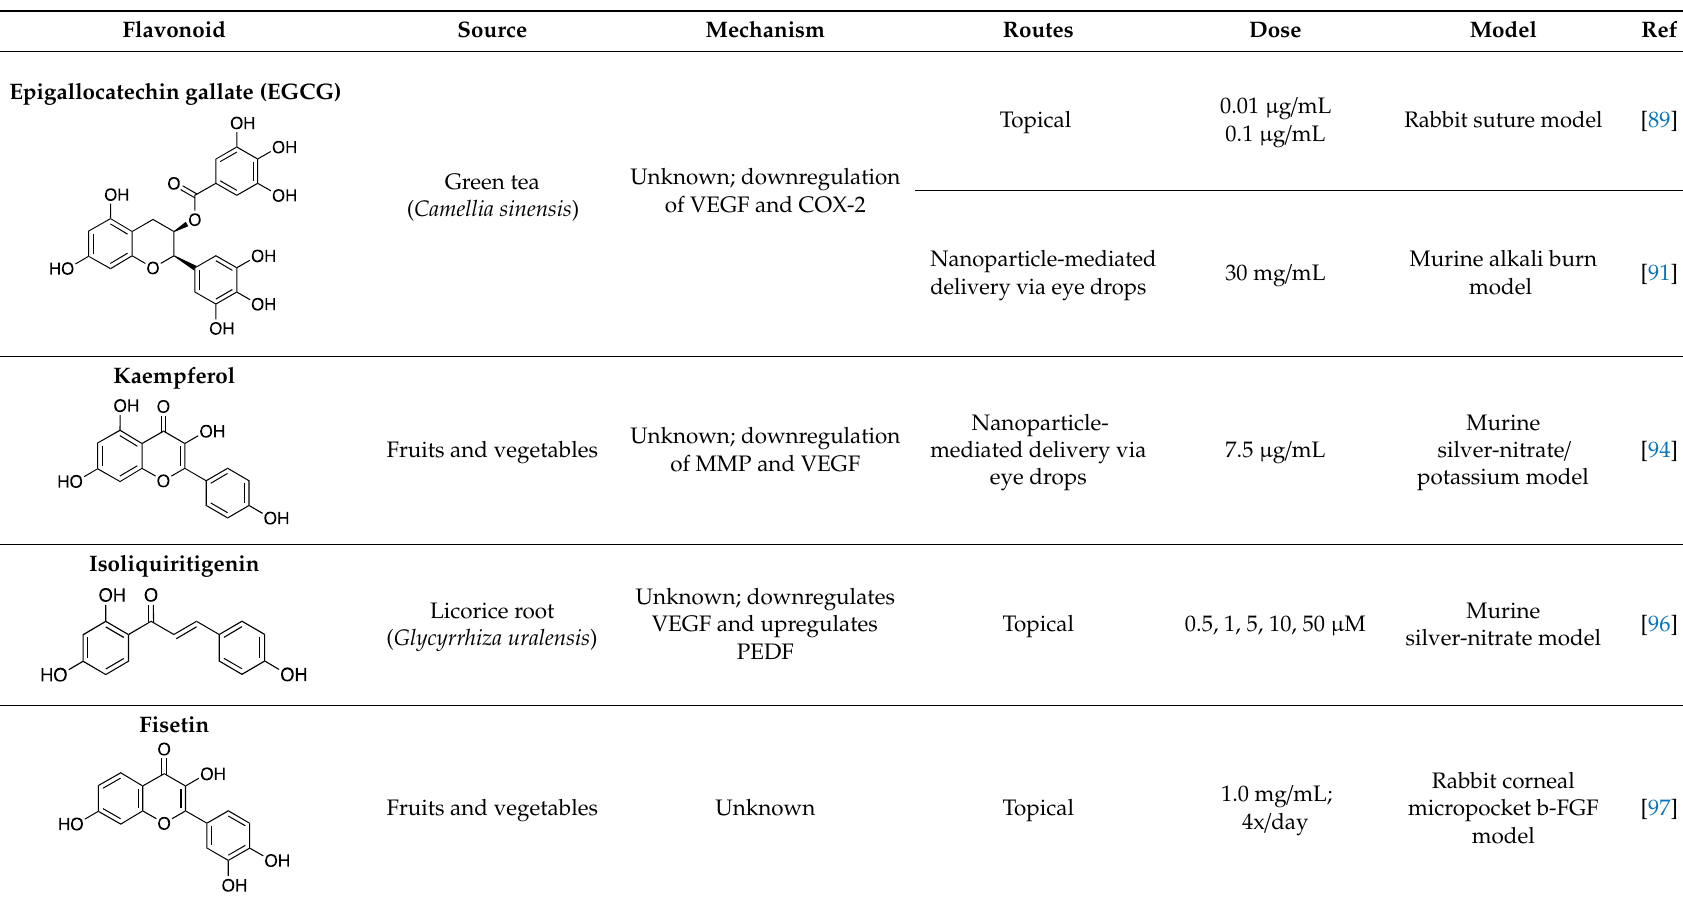
Table 4. Flavonoid polyphenols tested in CoNV models.